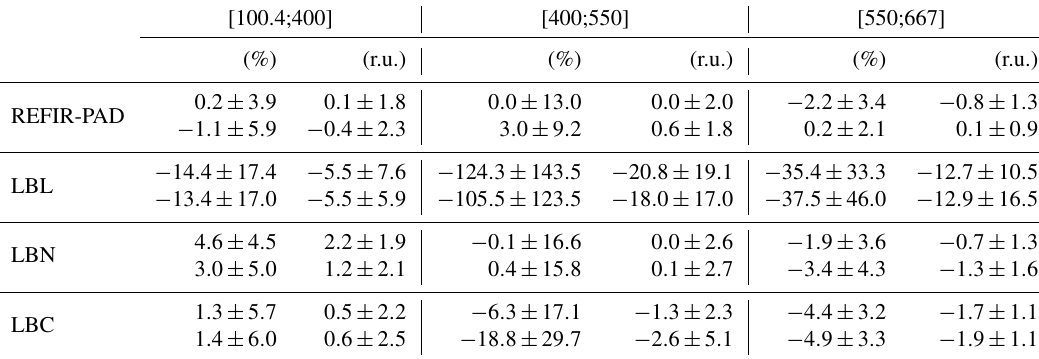
Table 1. Distribution of the differences and relative variations between the extension and the original spectra within the three bands (100.4– 400, 400–550 and 550–667cm − 1 ) for REFIR-PAD extension itself, REFIR-PAD extension based on LBLRTM (LBL), based on LBLRTM with added noise (LBN) and based on coupled LBLRTM (LBC). The first and second lines correspond to a linear and a logarithmic extension respectively. The values correspond to the median value ± 1 σ